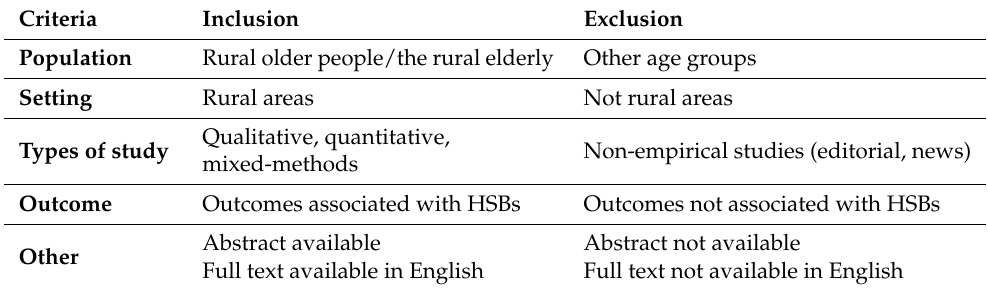
Table 1. Inclusion and exclusion